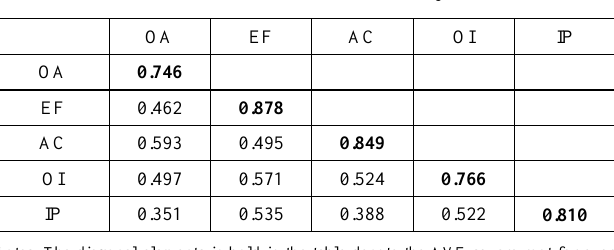
Table 4. Discriminant validity.